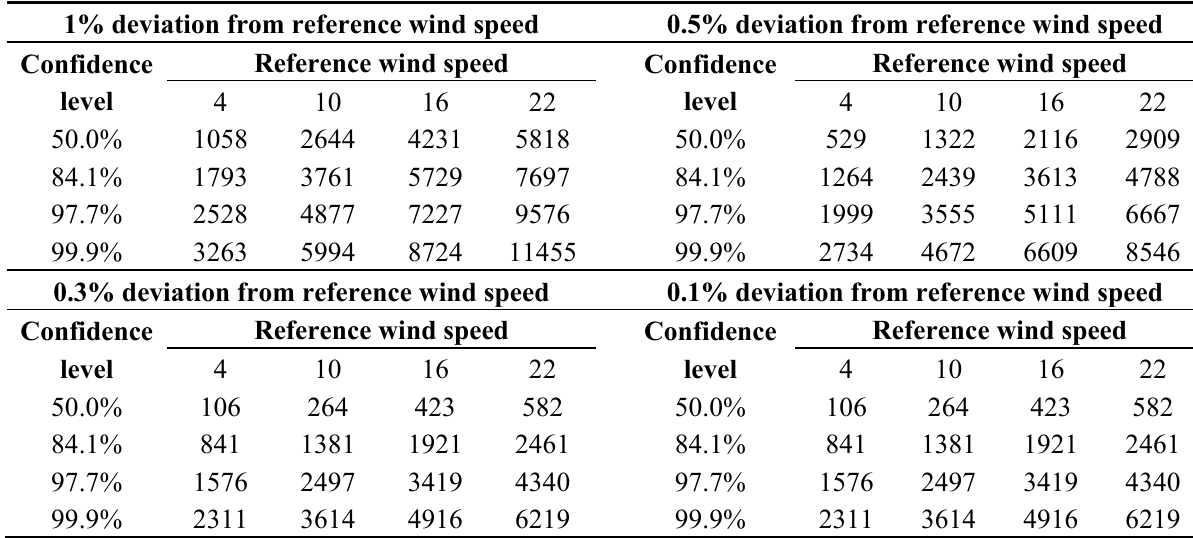
Table 3. Recalibration schedule (days after the initial calibration) of the IDR/UPM confidence level.